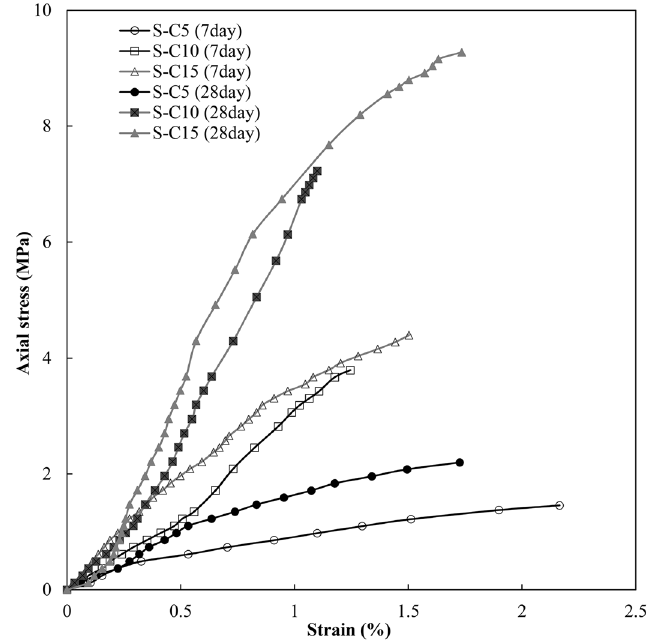
Fig. 7 The stress–strain curve for CSG mixtures (without fine additives) and cured at the ages of 7 and 28